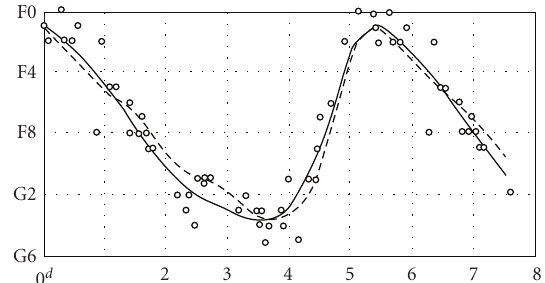
Figure 6: Relation of the light curve and spectral type for delta Cephei